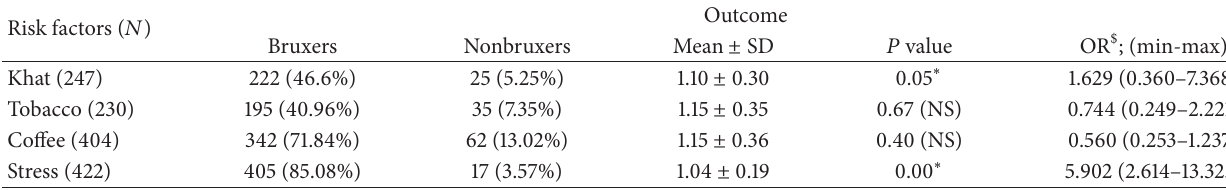
Table 3: Association of risk factors with bruxism.